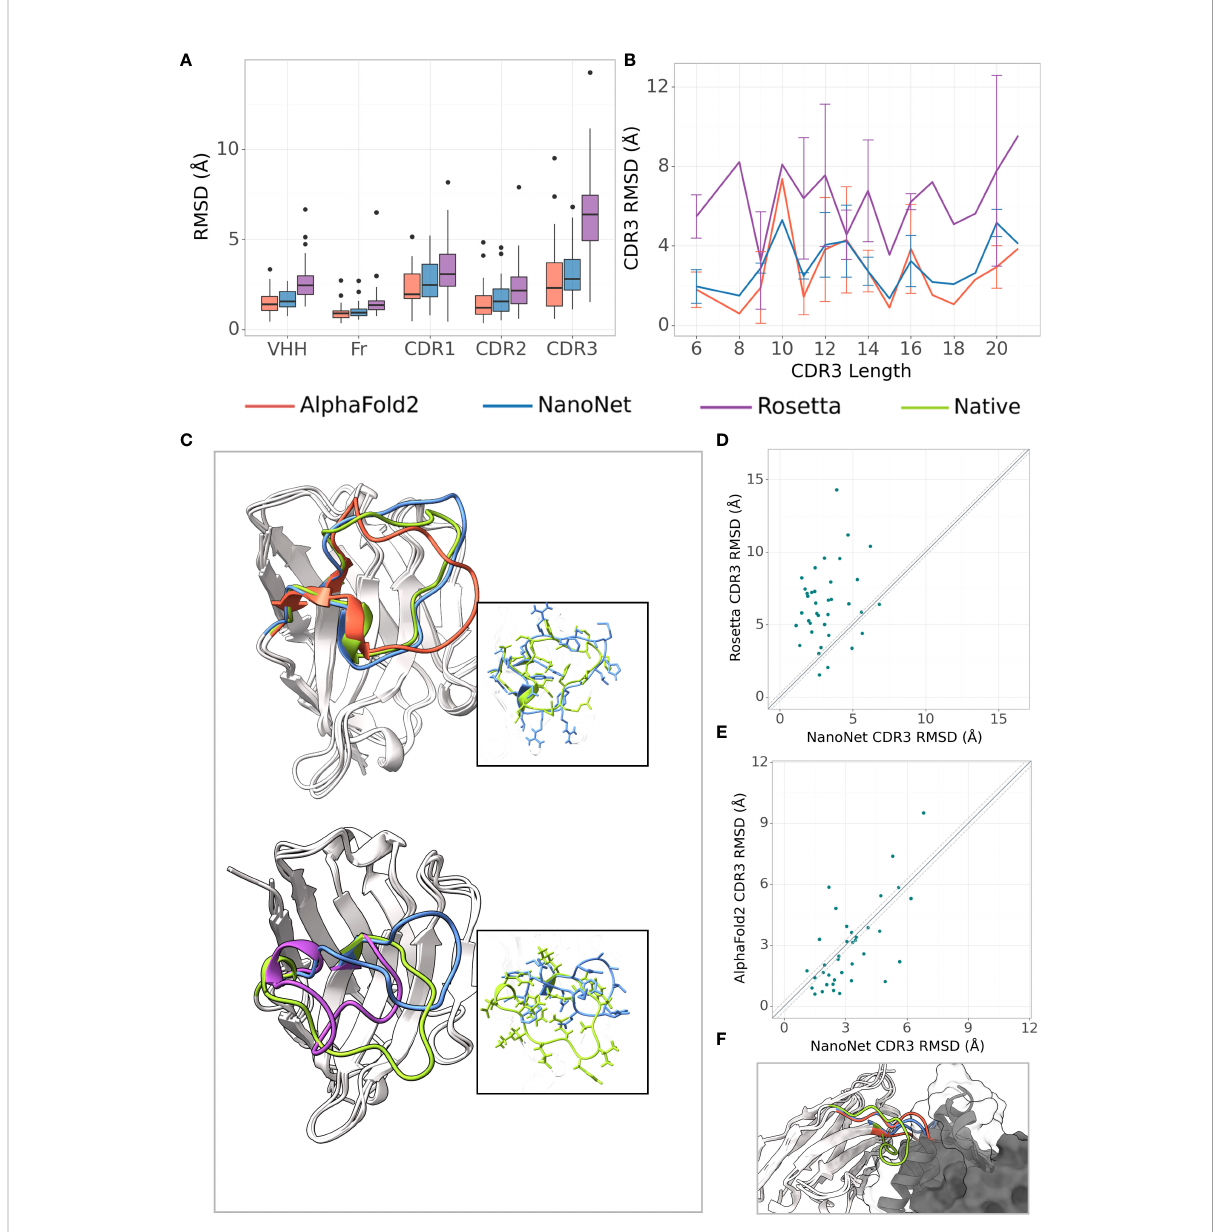
FIGURE 2 Nb modeling results. (A) Boxplots of RMSDs of the whole VHH region, framework, CDR1-3 loops for the Nb test set (37 Nbs), (B) Average RMSD of CDR3 loop as a function of loop length on the Nb test set (37 Nbs), (C) Test set examples of modeled structures by NanoNet (blue), RosettaAntibody (purple), AlphaFold2 (red) vs. experimental (green): PDB 6xw6 (top) - CDR3 RMSD 1.77Å, 4.06Å for NanoNet and AlphaFold2, respectively and 7n0r (bottom) - CDR3 RMSD 6.82Å,6.39A for NanoNet and RosettaAntibody, respectively, (D) CDR3 loop RMSD for NanoNet vs. RosettaAntibody, each dot represents a structure from the test set. The dotted line corresponds to 0.25Å RMSD, (E) Same as D for NanoNet vs. AlphaFold2, (F) Nb (PDB 6xzu) docked to its antigen, native structure – green, AlphaFold2 - red, NanoNet -